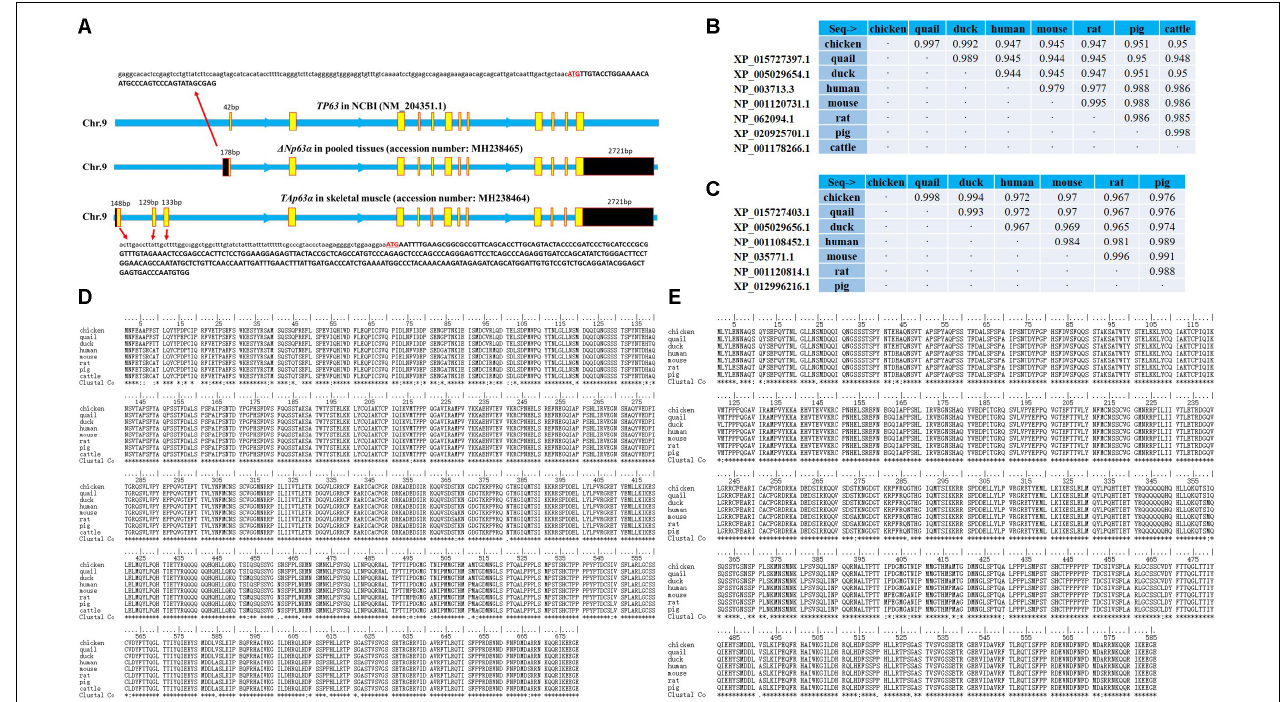
FIGURE 2 | TAp63 α and (cid:49) Np63 α are two conserved transcripts expressed in chicken tissues. (A) Genomic structure of the chicken TP63 gene. The yellow boxes indicate coding sequence regions, and the black boxes indicate the UTRs. The capital letters indicate coding sequences, and the lowercase letters indicate UTR sequences. (B) Percent identities of the chicken, quail, duck, human, mouse, rat, pig, and cow TAp63 α amino acid sequences. (C) Percent identities of the chicken, quail, duck, human, mouse, rat, and pig (cid:49) Np63 α amino acid sequences. (D) Amino acid alignment of TAp63 α proteins from chickens, quails, ducks, humans, mice, rats, pigs, and cattle. Conserved sequences are marked with asterisk within the Clustal Co sequences. (E) Amino acid alignment of (cid:49) Np63 α proteins from chickens, quails, ducks, humans, mice, rats, and pigs. Conserved sequences are marked with asterisks within the Clustal Co sequences. The data are the mean ± SEM of three cultures per group, and three wells per culture were assayed ( n = 9/treatment group). An independent samples t -test was used to analyze the statistical differences between groups. ∗ p < 0.05; ∗∗ p < 0.01.